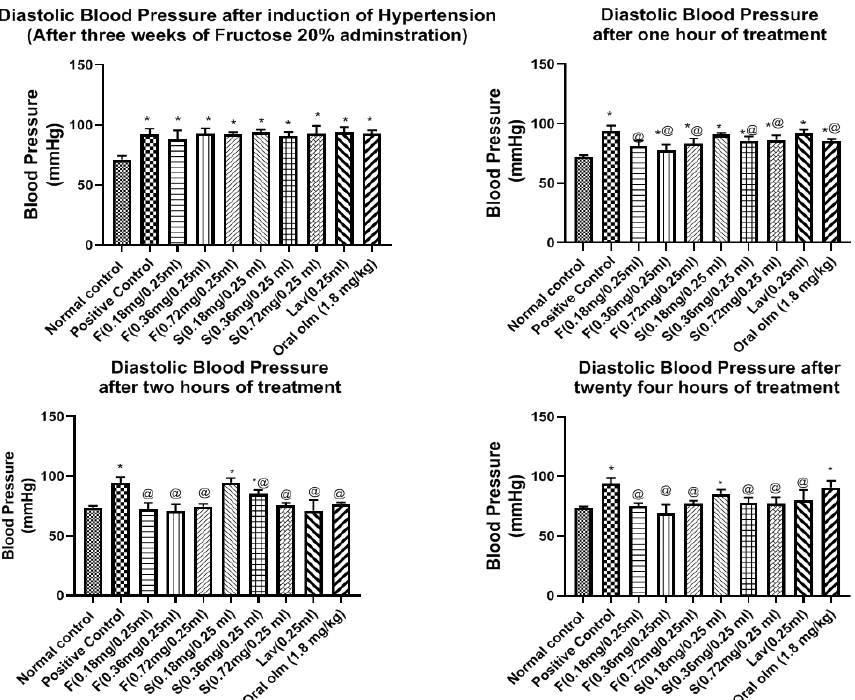
Figure 9. Diastolic blood pressure of the ten examined rats’ groups after three weeks of hypertension induction, and after 1, 2, and 24 h of treatment. Presented data are the mean ± SD (n = 3). Abbreviations: F = Transdermal oleogel formulation, S = Transdermal standard gel, Lav = Transdermal Lavender oil (0.25 mL), Oral Olm = Oral Olmesartan Medoxomil market tablet (Angiosartan ® Tablets). * Signi fi cantly di ff erent from the normal control group at respective time interval ( p < 0.05). @ Significantly di ff erent from positive group at respective time interval ( p < 0.05).